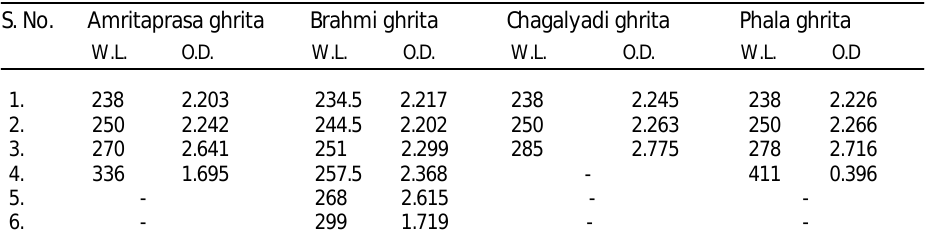
TABLE 4TABLE 4.. DATA OF UV-VISIBLE SPECTROPHOTMETRIC STUDY OF GHRITAS S.